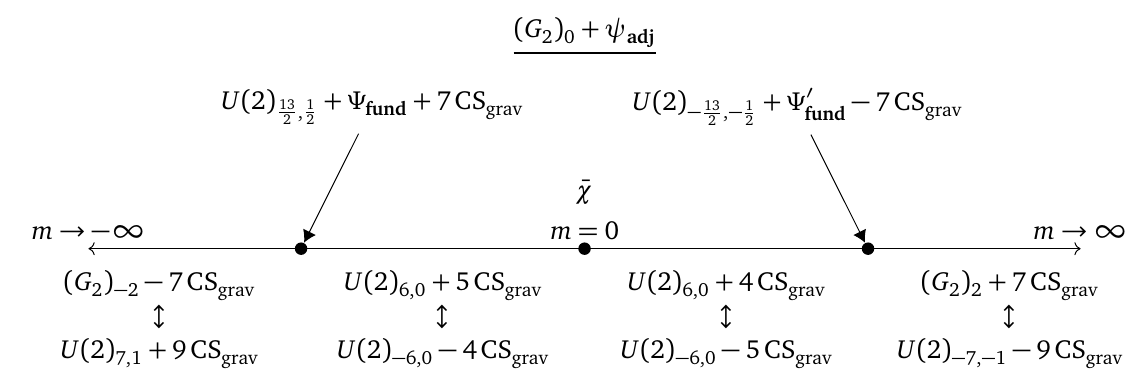
) Figure 1: A conjectural phase diagram of ( G coupled to an adjoint Majorana 2 0 fermion as a function of the fermion mass m . When m = 0 the theory is time-reversal invariant, and has N = 1 supersymmetry. At large | m | the IR is described by a TQFT visible semiclassically. As | m | is reduced there is a transition to a quantum phase. This transition is weakly coupled in dual variables with a U ( 2 ) gauge field and a fun- damental fermion. At m = 0 there is also massless fermion ¯ χ which is the Goldstino arising from the expected spontaneous breaking of supersymmetry [ 30 ] . In each phase, we also indicate the coefficient of the gravitational Chern-Simons term which can be used as a consistency check on the phase diagram (see section